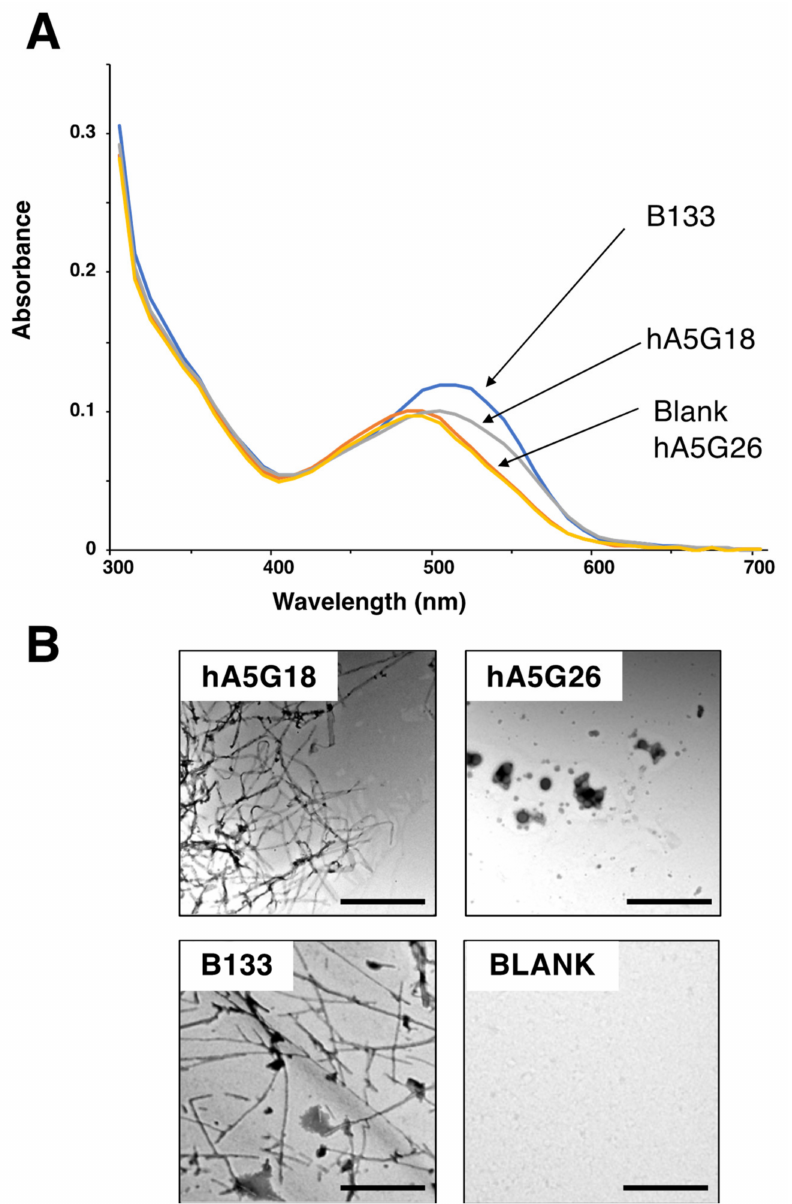
Figure 1. Congo red staining and electron micrographic analysis of peptides. ( A ) Absorption spectra of peptides with Congo Red were recorded from 300 to 700 nm. ( B ) Electron micrograph of amyloid- like fibrils formed from peptides. Peptide solution (1 mM) was diluted 1:0 to 1:4 with water and smear solution on a grid mesh with carbon-coated Formvar film. Then the specimen was negatively stained with a 2% aqueous solution of uranyl acetate and observed using an electron microscope. Bar = 500